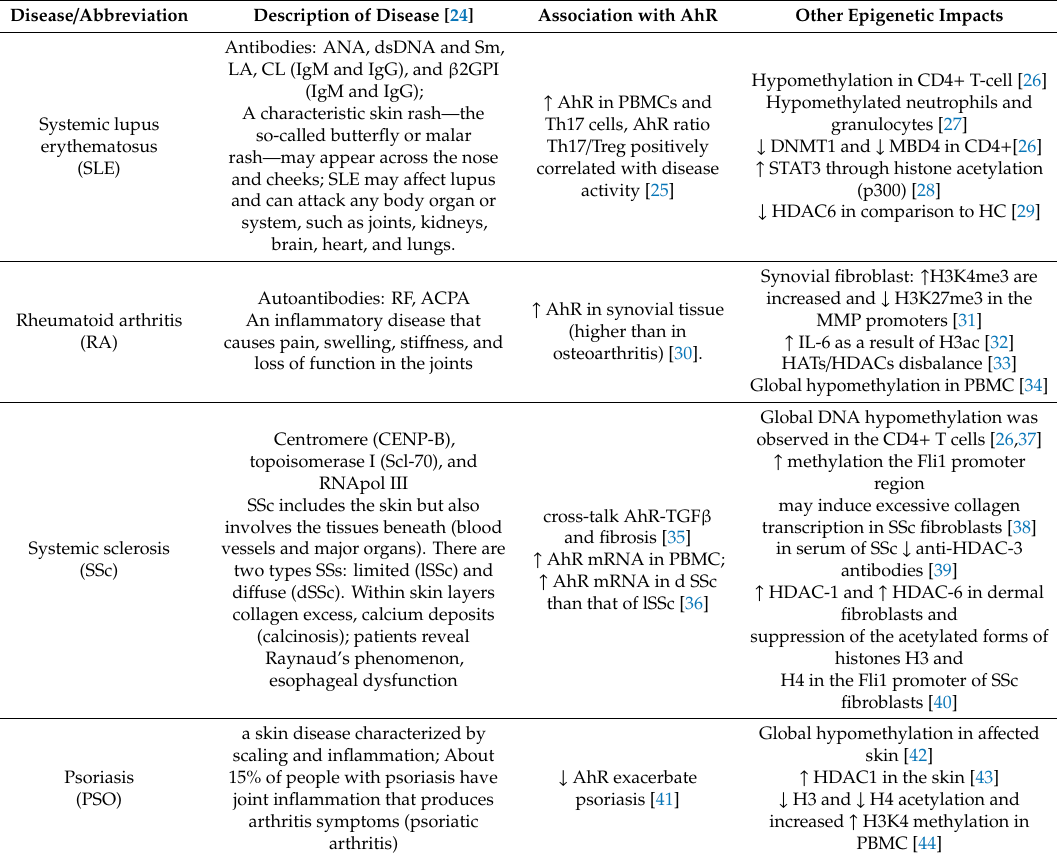
Table 1. Characteristic of selected autoimmune diseases and their association with epigenetics mechanisms and aryl hydrocarbon receptor (AhR)